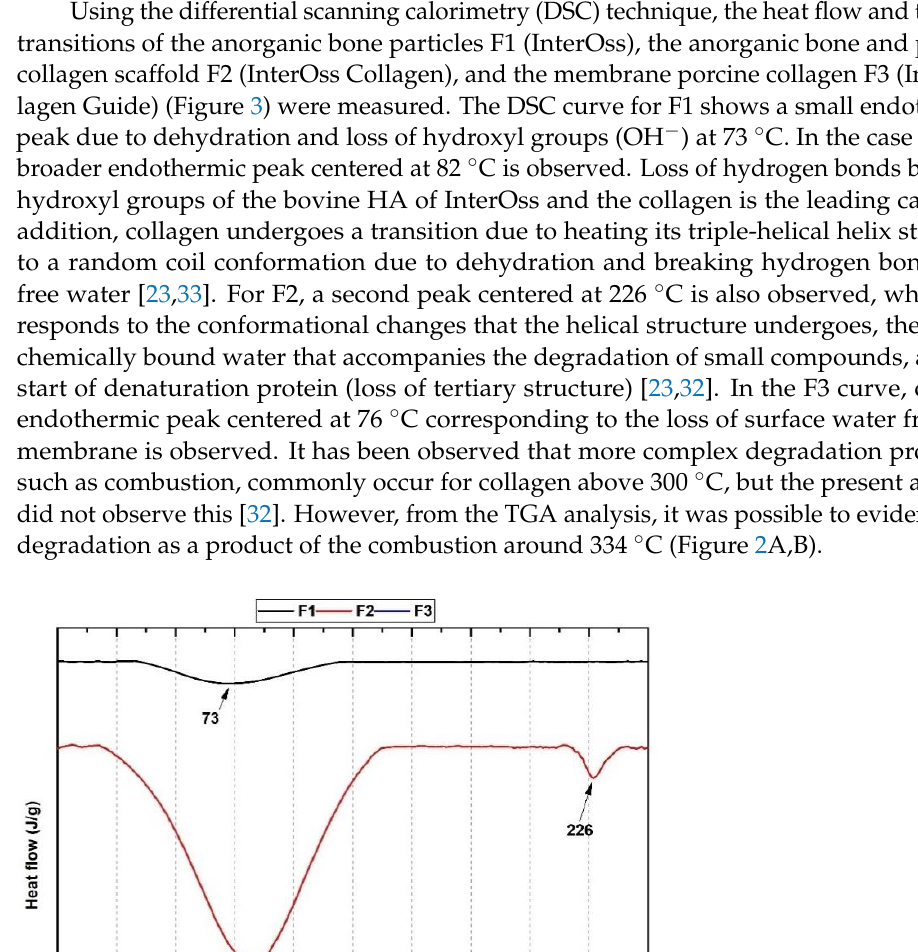
Figure 4. Cysts and larvae of Artemia salina. ( A ) Dry cysts at 3×. ( B ) Hydrated cysts at 24 h at 3×. Images were taken with a stereoscopic microscope. In this research, F1 (InterOss) and F2 (InterOss Collagen) have a high content of par- ticulate material. For that reason, they can be ingested if their size is small enough or if their dilution due to the effect of seawater produces residues smaller than 50 µm [42]. In